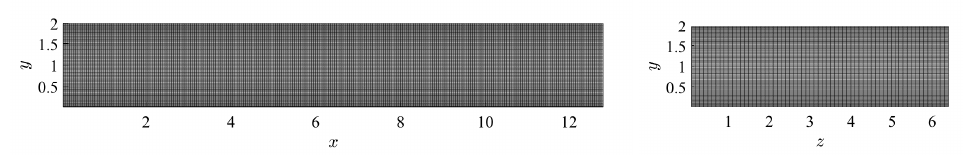
Figure 2. Mesh geometry in the present simulation, viewed in the x – y plane ( left ) and the z – y plane ( right ).